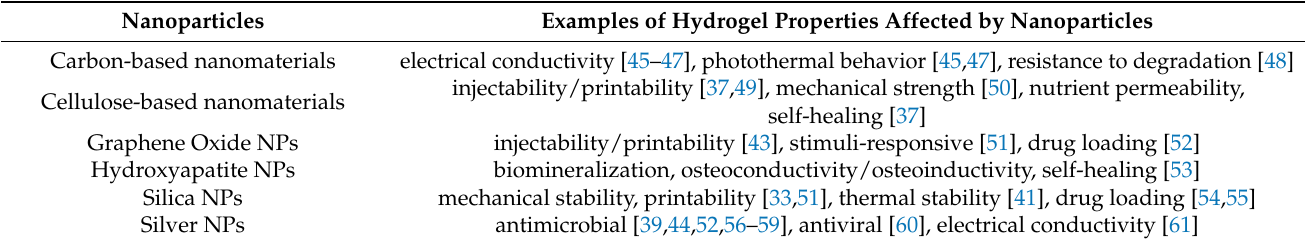
Table 2. Representative examples of nanomaterials described in this review and their effects on hydrogel properties.